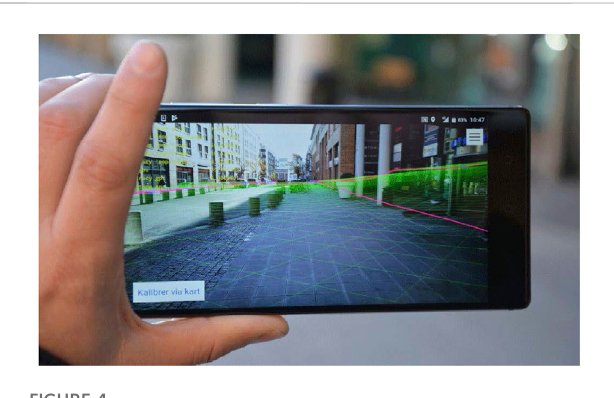
FIGURE 4 The BorderGO prototype developed by the Norwegian Mapping Authority. Available at https://github.com/kartverket/BorderGo. Published with permission.